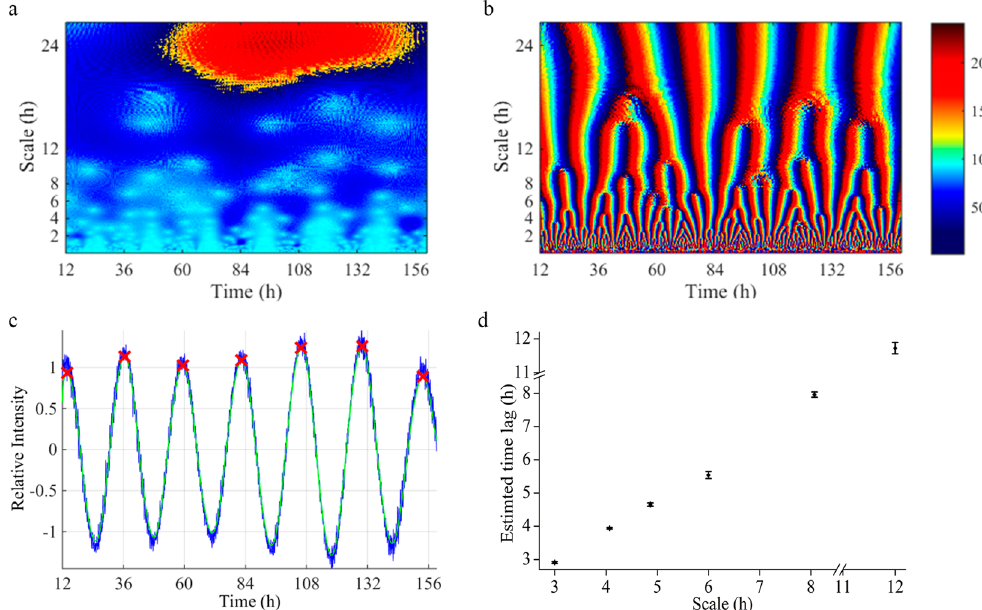
Figure 4. Wavelet analysis of ambulatory activity time series. Amplitude plots of complex valued Morlet transform: ( a ) Modulus, and ( b ) phase angle. The x -axis represents time (6.5 days) and the y -axis indicates the scale of the wavelet used (from 6 min to 26 h). The wavelet decomposition reveals an overall self-similar fractal structure particularly noticeable at low scales, while the periodic behavior of the series is more clearly depicted at larger scales. Similar plots were obtained for all animals studied. ( c ) An example of estimation of time lag between peaks in the relative intensity of the real wavelet coefficients at the 24 h scale is shown. Cross symbols in red (x) indicate peak values, while the distance between peaks is the lag time. For examples of lag time estimation for smaller scales see Supplementary Fig. 5. ( d ) Mean ± SEM of the lag time between peaks is represented for all 24 animals evaluated as a function of the time scale. Notice that the lag time corresponds with the time scale evaluated, hence providing analytical confirmation of the presence of these rhythms in the locomotor activity time series. Wavelet analysis was performed on actograms with 6 min bins in order to reduce noise (see Supplementary Fig. 3 for comparison with wavelet analysis performed on complete time